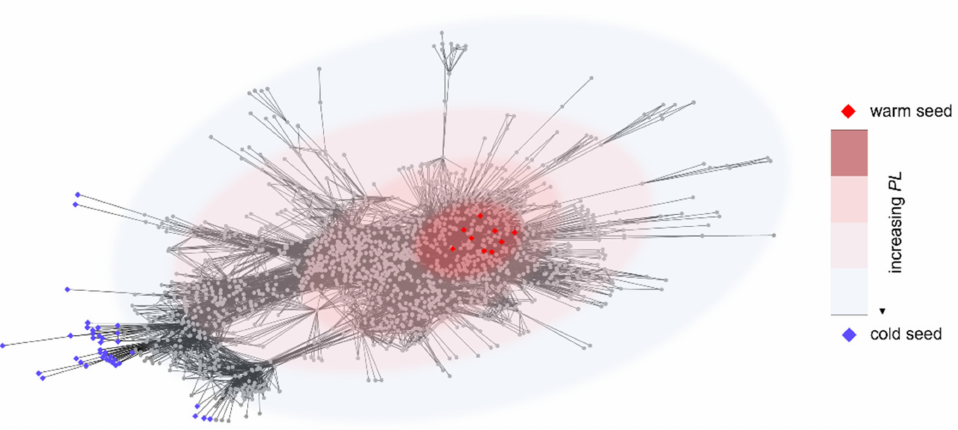
Figure 1. Example of network-based distance between warm seeds (red diamonds) and cold seeds (blue diamonds). The color of background ovals codes for the path length (PL) between WSs and CSs. Its functioning requires three sequential phases described in detail in the following